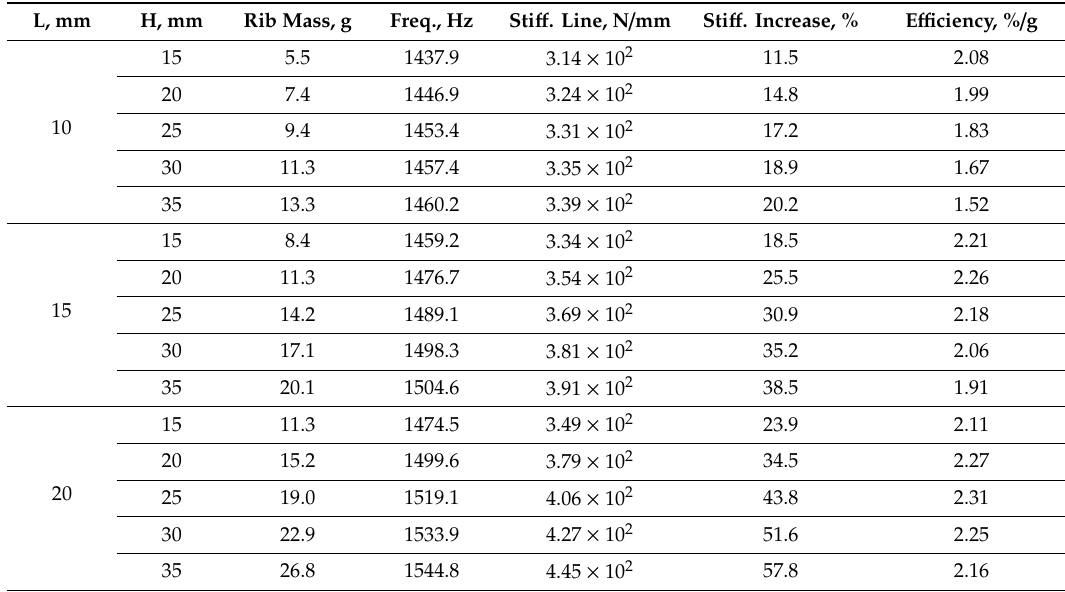
Table 7. Results of parameter study